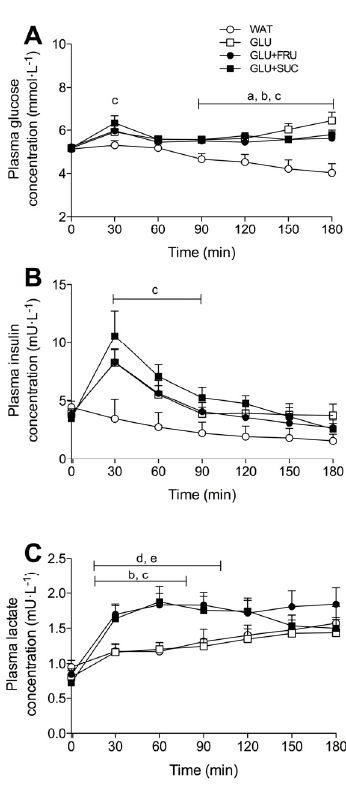
Figure 3. Plasma glucose ( A ), insulin ( B ), and lactate ( C ) concentrations during exercise without ingestion of carbohydrate (WAT), with the ingestion of glucose (GLU), with the ingestion of glucose and fructose (GLU + FRU), or with the ingestion of glucose and sucrose (GLU + SUC). Data were analsysed with a two ‐ way repeated measures ANOVA (time ‐ treatment). Data are presented as means ± SEM. N = 10; a, denotes GLU significantly different from WAT; b, denotes GLU + FRU significantly different from WAT; c, denotes GLU + SUC significantly different from WAT; d, denotes GLU + FRU significantly different from GLU; e, denotes GLU + SUC significantly different from GLU ( p < 0.05).